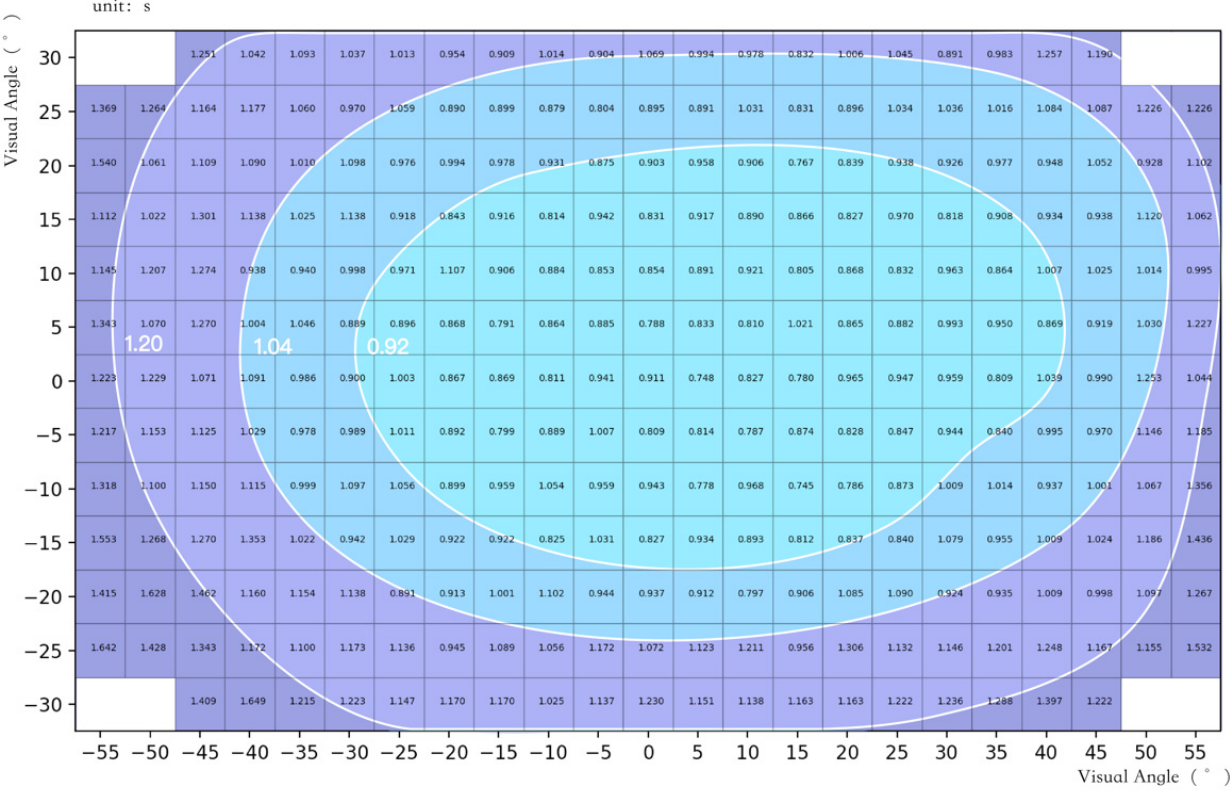
Figure 4. Contour map on movement time.